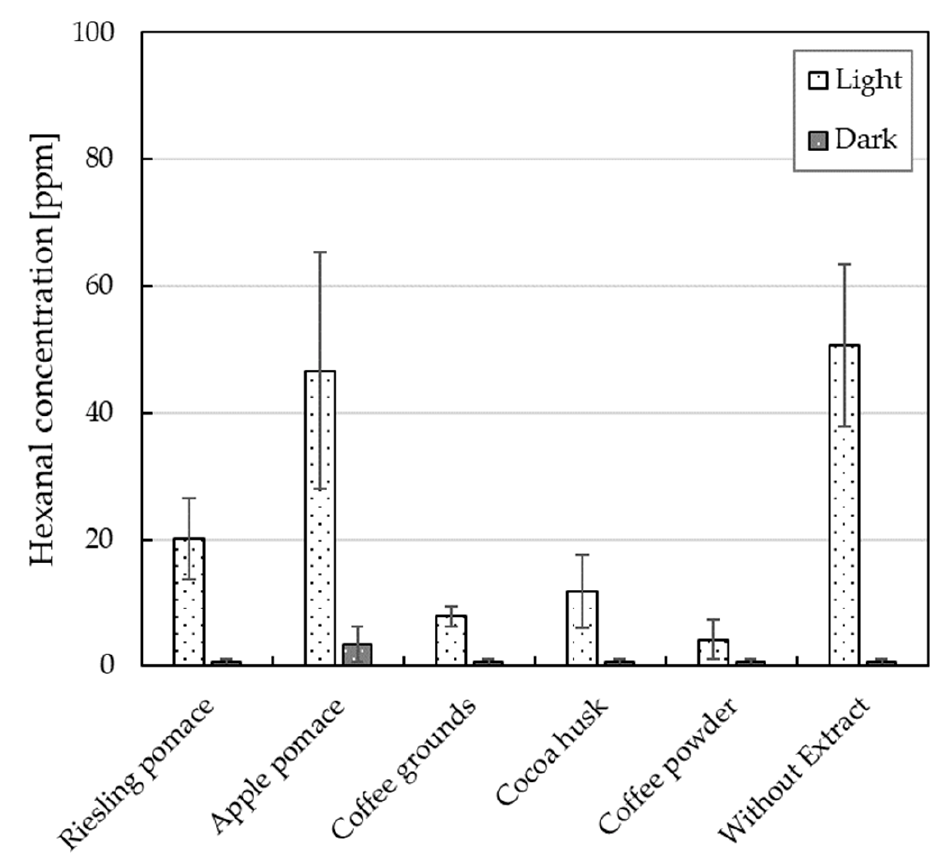
Figure 7. Concentration of hexanal in O/W emulsions with plant extracts. The figure shows the concentration of hexanal in mg/L as a fat oxidation product after a storage time of 90 days for the O/W emulsions with and without extract in light and darkness, respectively, as mean values ( n = 3) with standard deviation (SD).